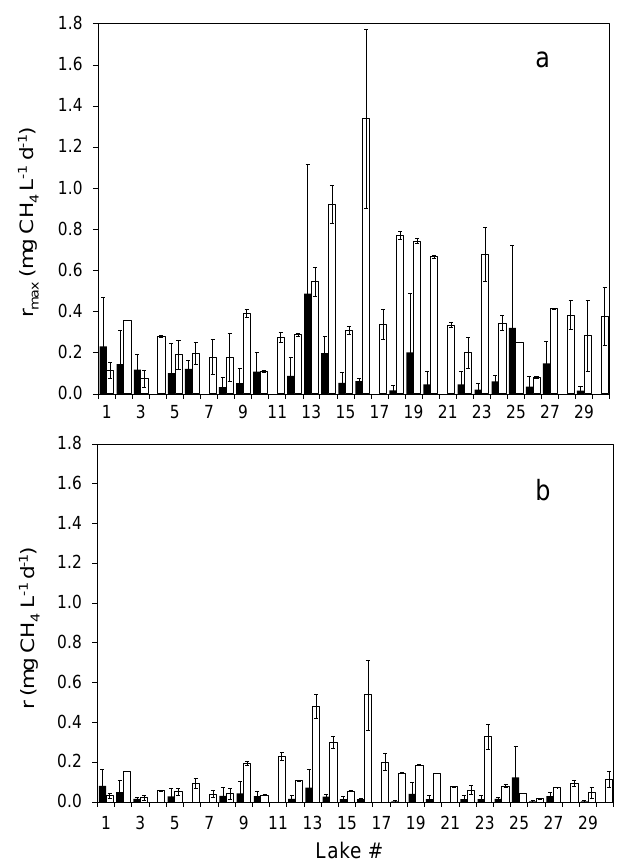
Figure 5. (a) CH 4 oxidation potential ( r max ) and (b) CH 4 oxidation rates observed in 30 lakes along a north-south transect (left-right) in Alaska during the summer (white bars) and the winter (black